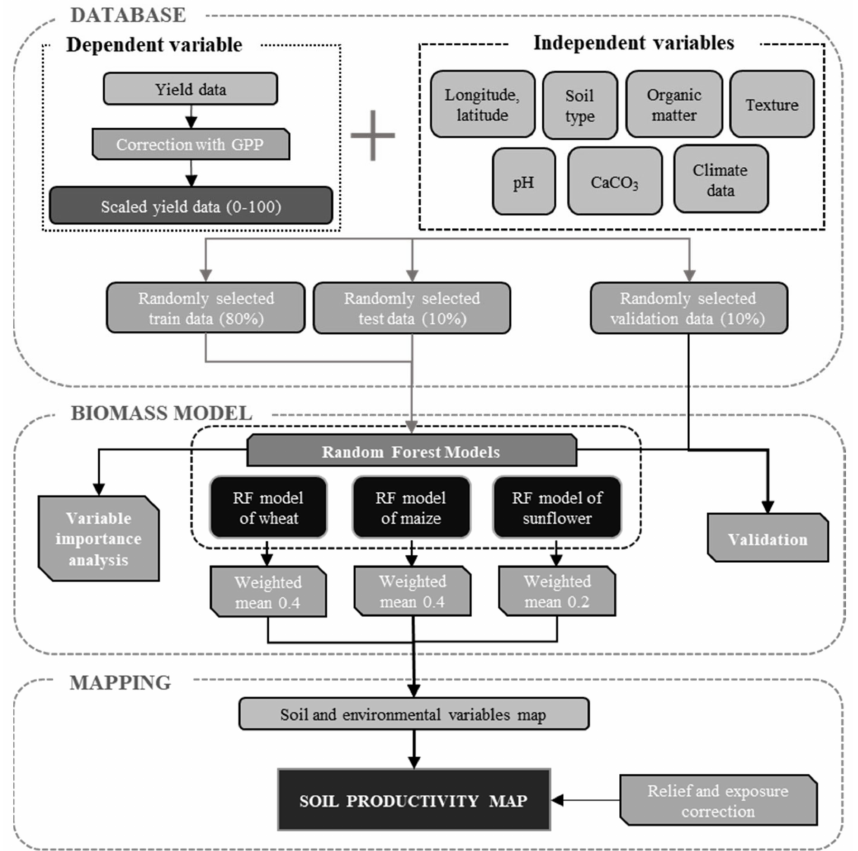
Figure 2. Flowchart of land evaluation modeling